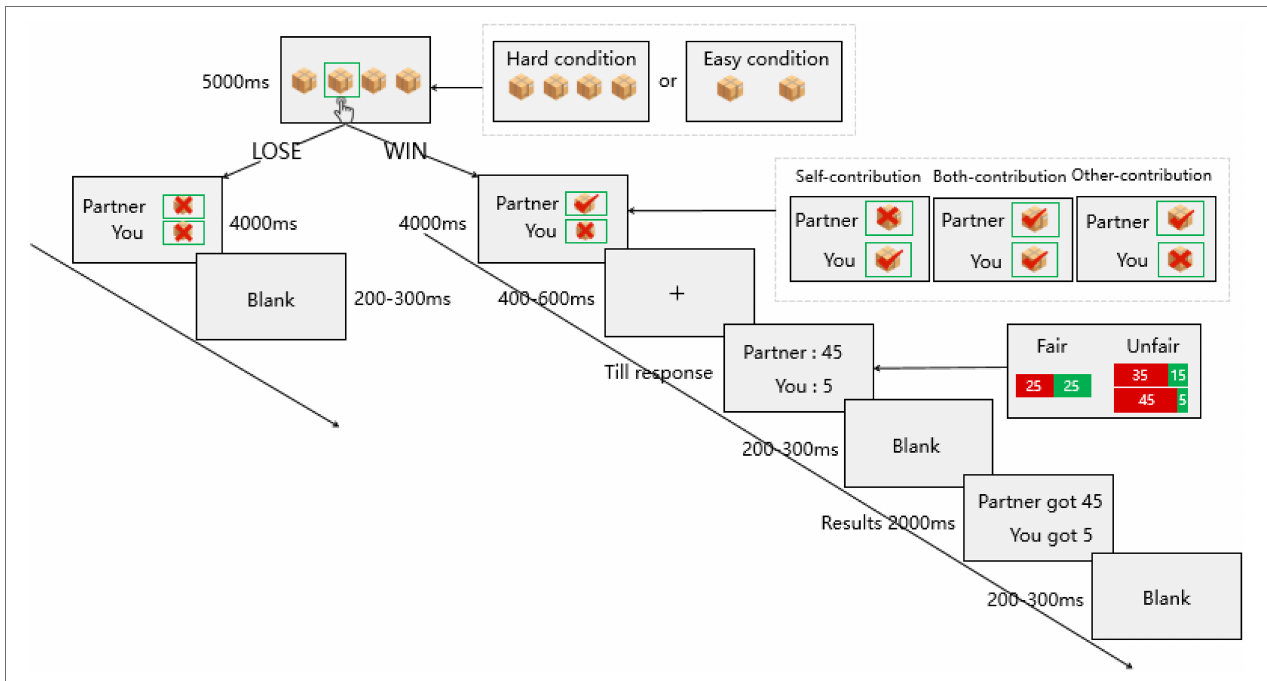
FIGURE 1 | Sequence of events within each